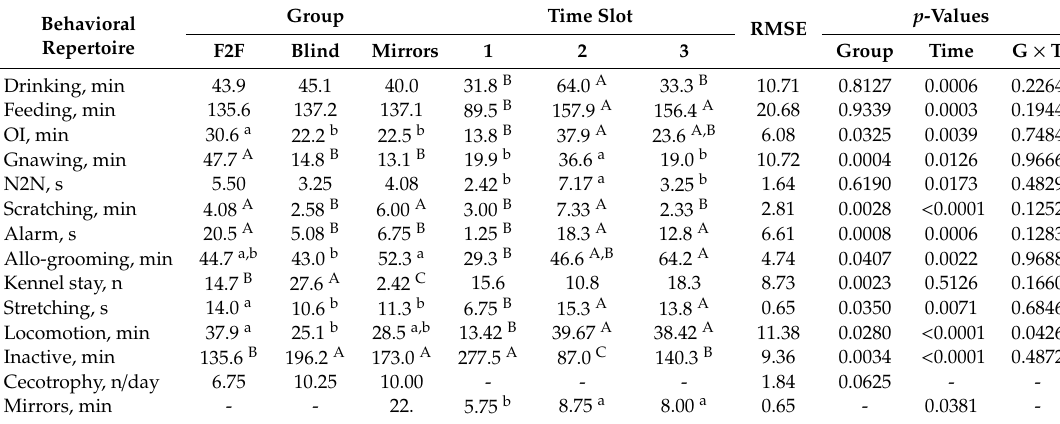
Table 1. Rabbits behavioral repertoire (means of four 24 h recordings). Time slot: 1 = 8:00 am–4:00